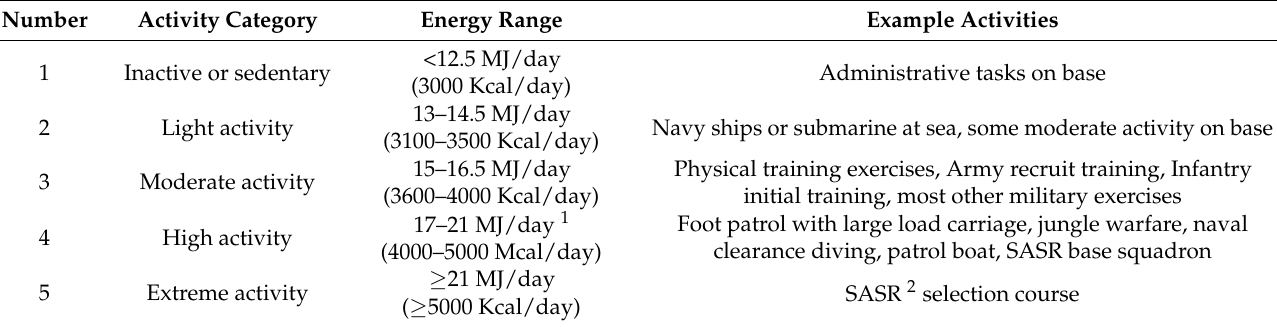
Table 1. ADF Activity Categories (from [4] p.